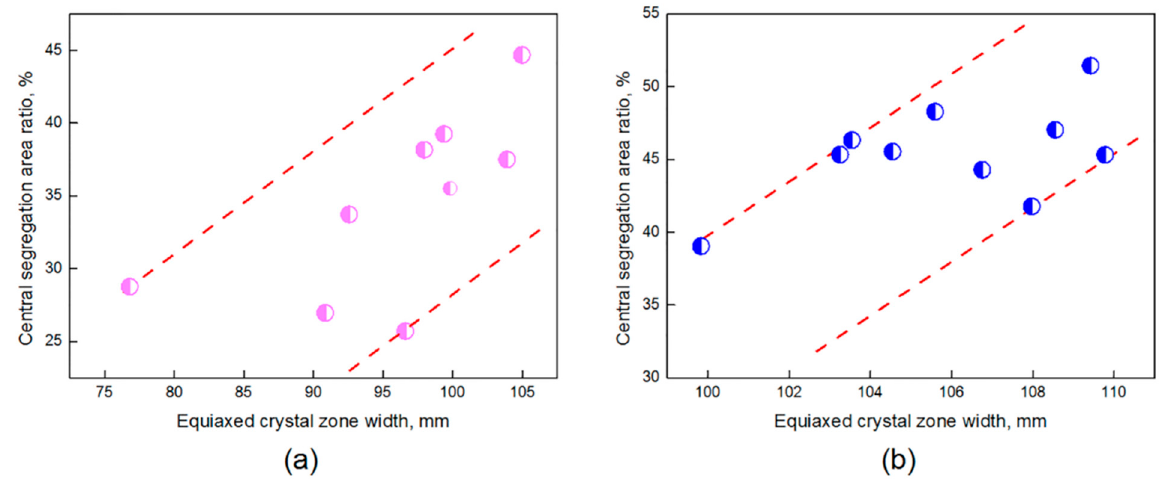
Figure 8. Distribution of central segregation area ratio and equiaxed crystal zone width under hysteretic conditions of billet No. 1 ( a ) and billet No. 2 ( b ). The hysteresis number of the two billet samples are 7 and 6, respectively.